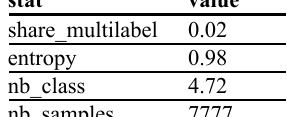
Table 1. Global statistics of the dataset Table 1 gives global statistics with: